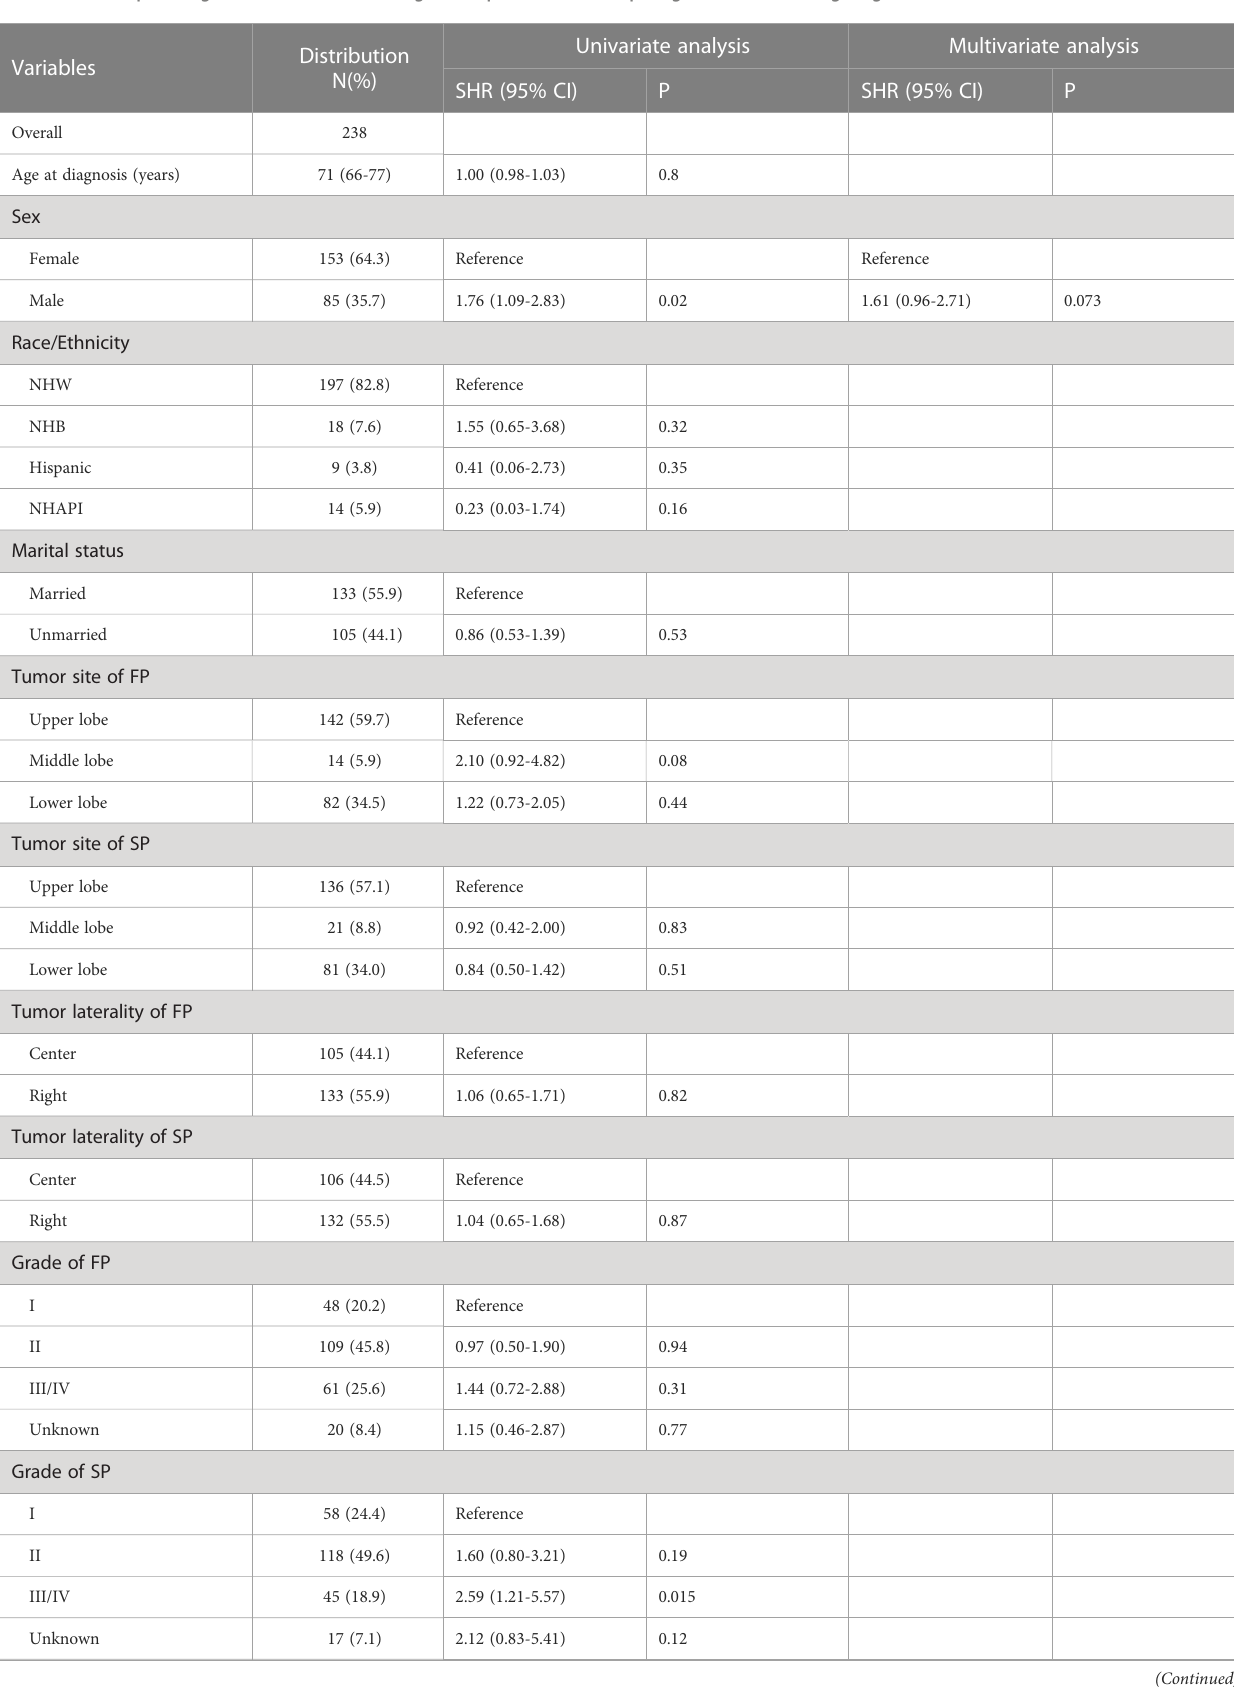
TABLE 1 Clinicopathological characteristics of stage IA SP patients and competing risk model investigating the risk factors of their